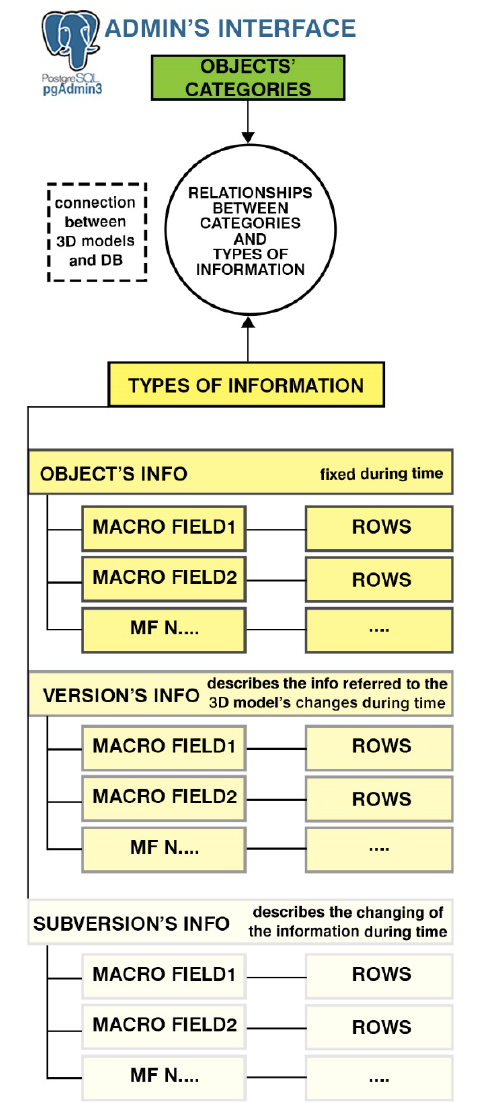
Figure 1. The scheme of the system’s architecture: the categories assigned to 3D models are connected to the DB through relationships; the DB contains three typologies of information: object, version, and subversion. Each of these types is divided in macro fields (e.g. 3D model origin, cartographic origin, wall